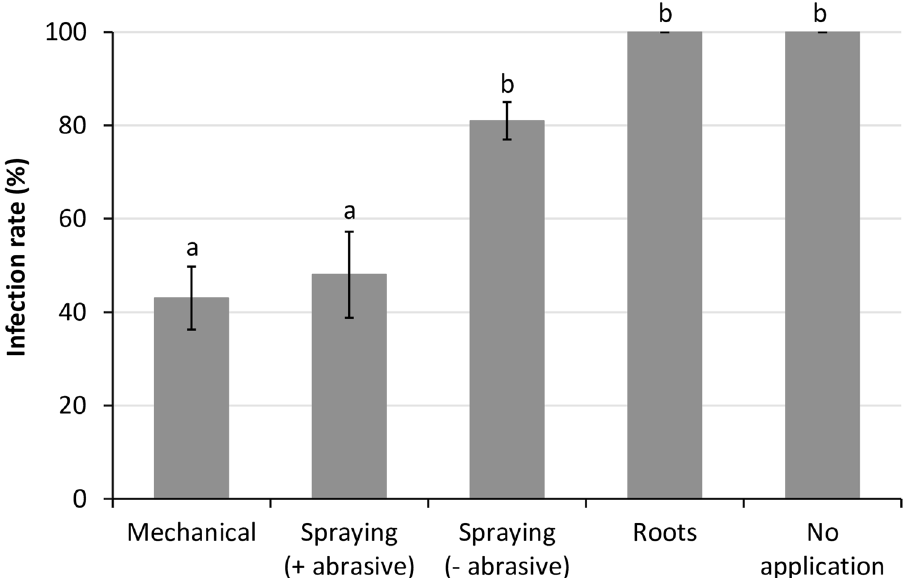
Figure 3. Effects of the application of dsRNA molecules homologous to tomato mosaic virus (ToMV) sequence on the viral infection rate in tomato plants. Testing application methods of ToMV-dsRNA: mechanical, spraying with abrasive (+ abrasive), spraying without abrasive (– abrasive), and root immersion in dsRNA solution (roots). The positive control consisted of non-treated plants (no dsRNA application). ToMV was mechanically inoculated 24 h after application. Infection rate was determined at 7 dpi using the number of positive plants by indirect-ELISA, and calculated based on the number of infected plants out of total plants used in each treatment. The results are expressed as average values of 10 to 12 plants in 3 independent trials. Bars represent the respective standard errors. Letters above error bars indicate significantly different results based on Tukey test ( p < 0.05).